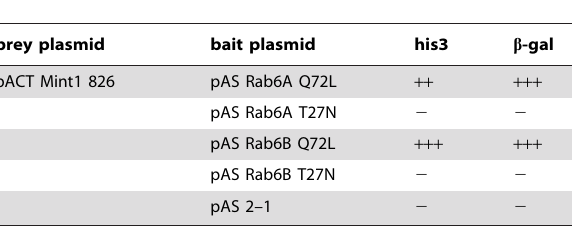
Table 3. Mint1 826 interacts with GTP-bound Rab6.